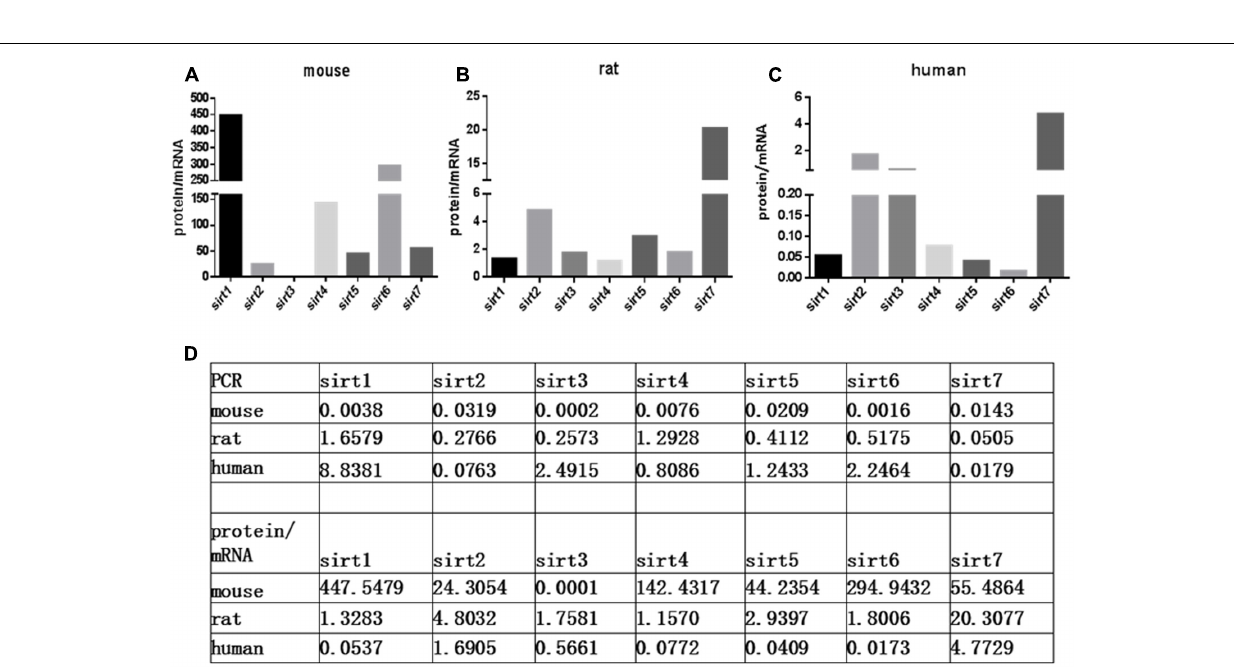
FIGURE 3 | Relative Sirtuin protein to mRNA ratios in mouse, rat, and human retinal neurons. The ratios of protein levels from western blot to mRNA levels from Real-Time PCR are denoted on the Y -axis for each Sirtuin family member ( X -axis) in the retinas of mice (A) , rats (B) , and humans (C) . Supplemental data about PCR and protein/mRNA are displayed (D)